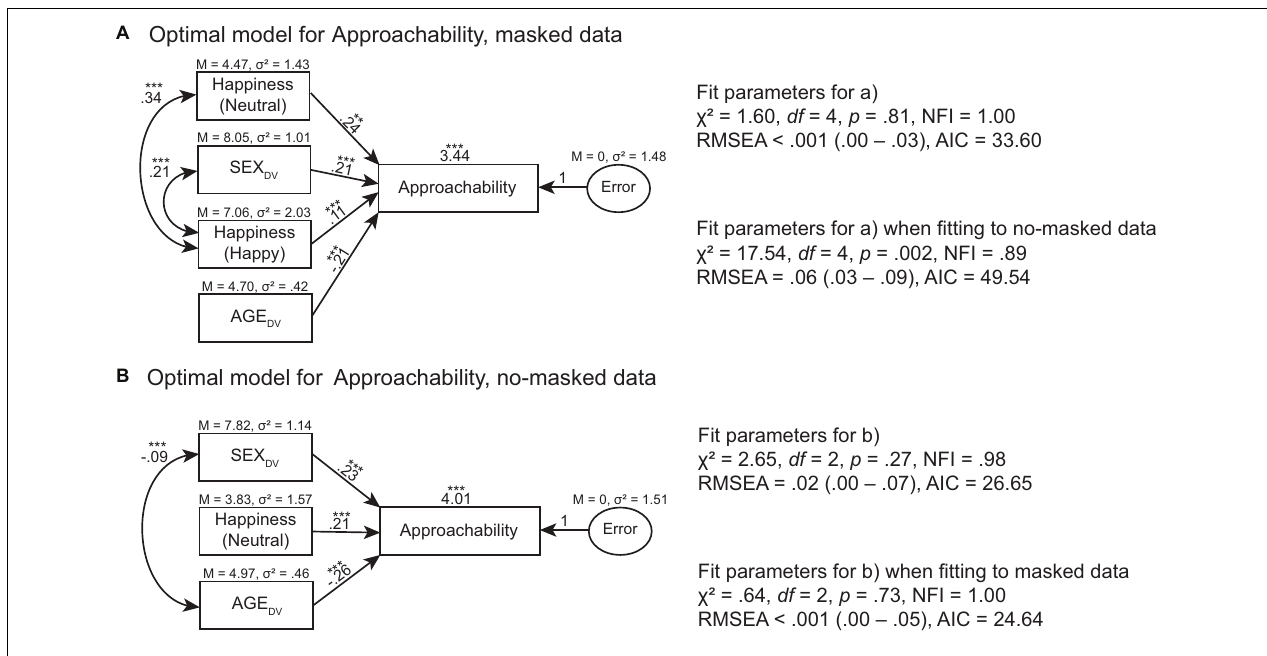
Optimal model for Approachability, no-masked data